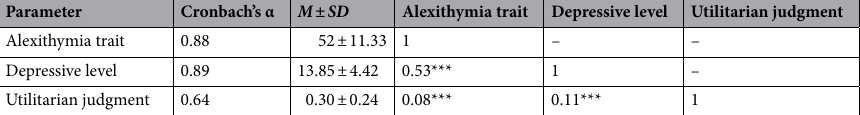
Table 2. Overview on the descriptive statistic results of sample ( N = 1775). * p < 0.05, *** p <